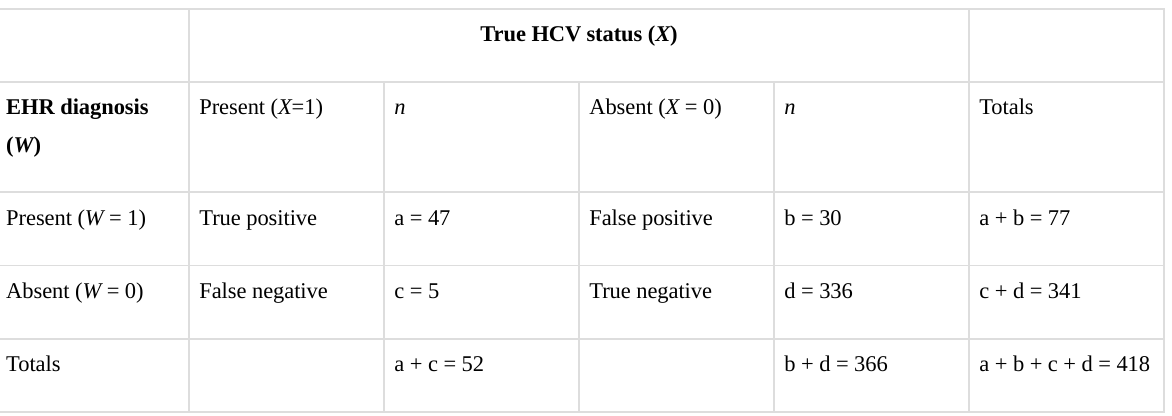
Table 2. Contingency table of an EHR indicator of HCV by true HCV status in the validation